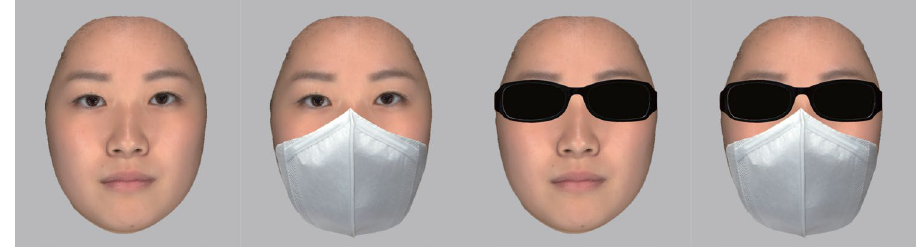
Fig. 1 Examples of facial stimuli used in this experiment. From left to right, the presented images illustrate example faces in the no occlu- sion, face mask, sunglasses, and combination of face mask and sunglasses conditions, respectively. Note that these faces were not actually used in this experiment. In order to protect the privacy of models, these example faces were average faces generated from three